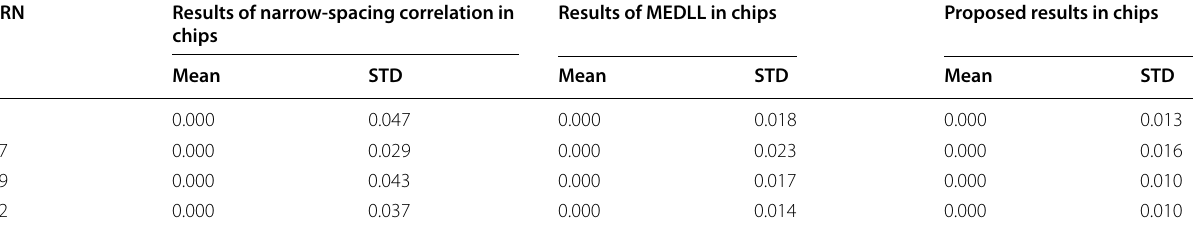
Results of MEDLL in